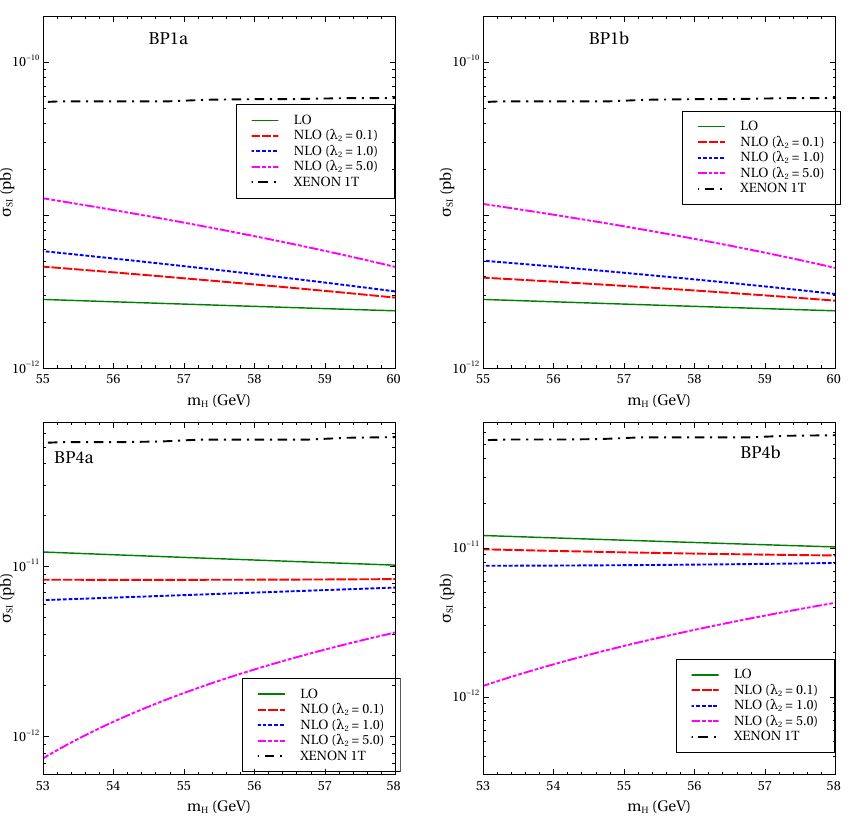
Figure 7 . Variation of the spin-independent cross section with the DM mass for BP1a, BP1b, BP4a and BP4b. The color coding can be read from the legends.